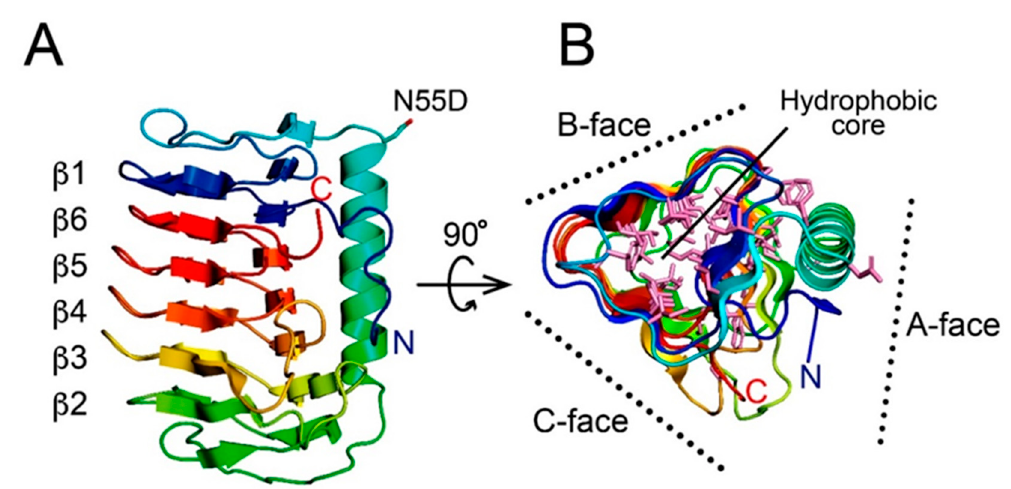
Figure 2. The crystal structure of Anp IBP (7BWX.pdb). ( A ) Overall structure of Anp IBP represented with ribbon model colored in gradation from blue (N-terminus) to red (C-terminus). The six β -helical loops are irregularly aligned in the order β 1– β 6– β 5– β 4– β 3– β 2. ( B ) Structural view of Anp IBP along the β -helical axis, showing that the β -helical fold is a triangular shape on which the A-, B-, and C-faces are defined. A large hydrophobic region is present at the center of the triangle. The long α -helix is stabilized on the A-face through additional hydrophobic cores.